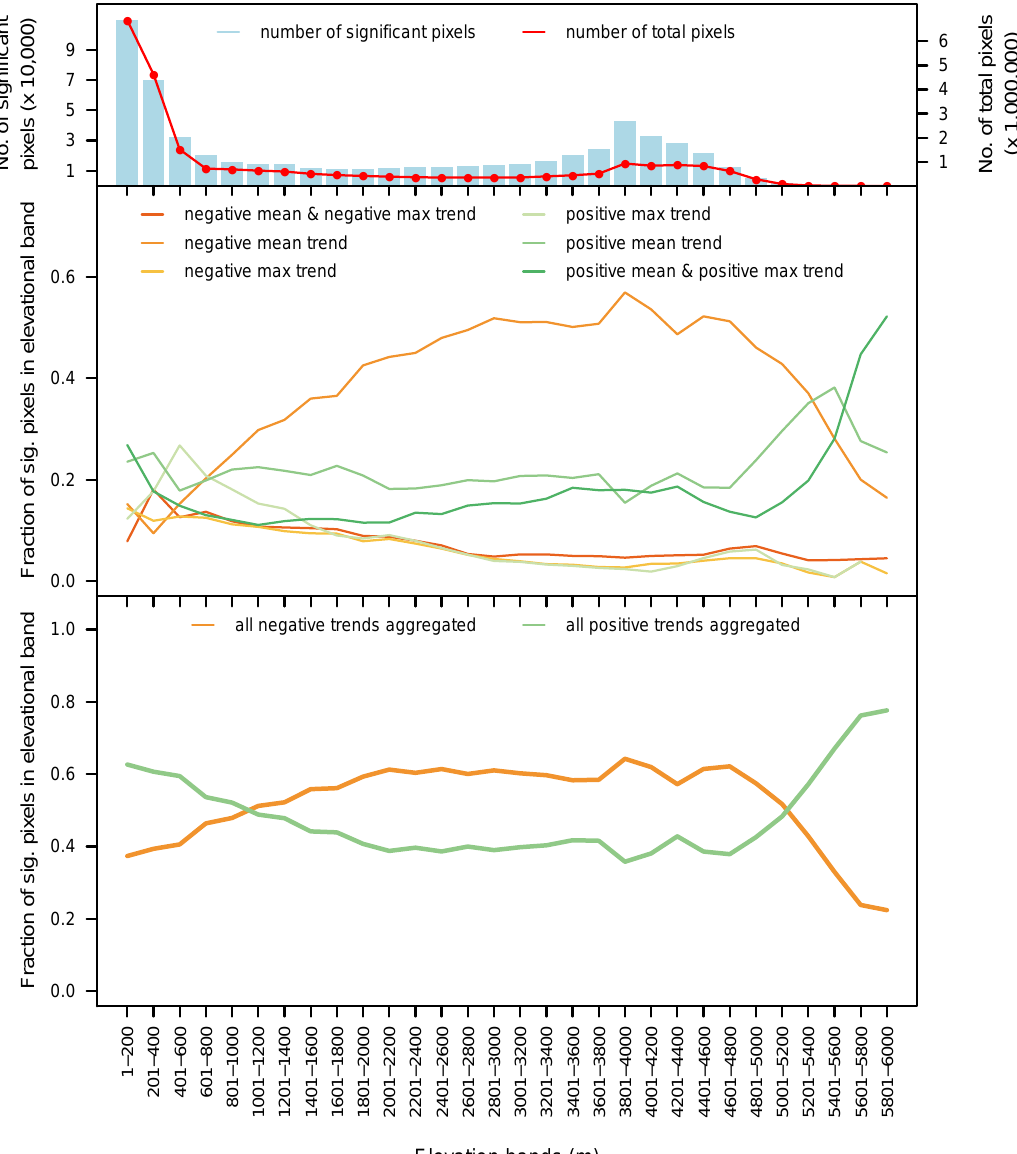
Figure 5. Greening and browning trends by elevation classes for all Peru. The top panel represents the total number of pixels (red line) and the number of statistically significant pixels (blue bars). The middle panel displays all six trend types (see Table 1 for confidence levels). The bottom panel displays all size trend types aggregated. Across the elevation gradient, greening and browning varies: greening dominated at elevations < 1000 m, then switching to browning > 1000 m and < 5000 m, and greening at the highest elevations over 5000